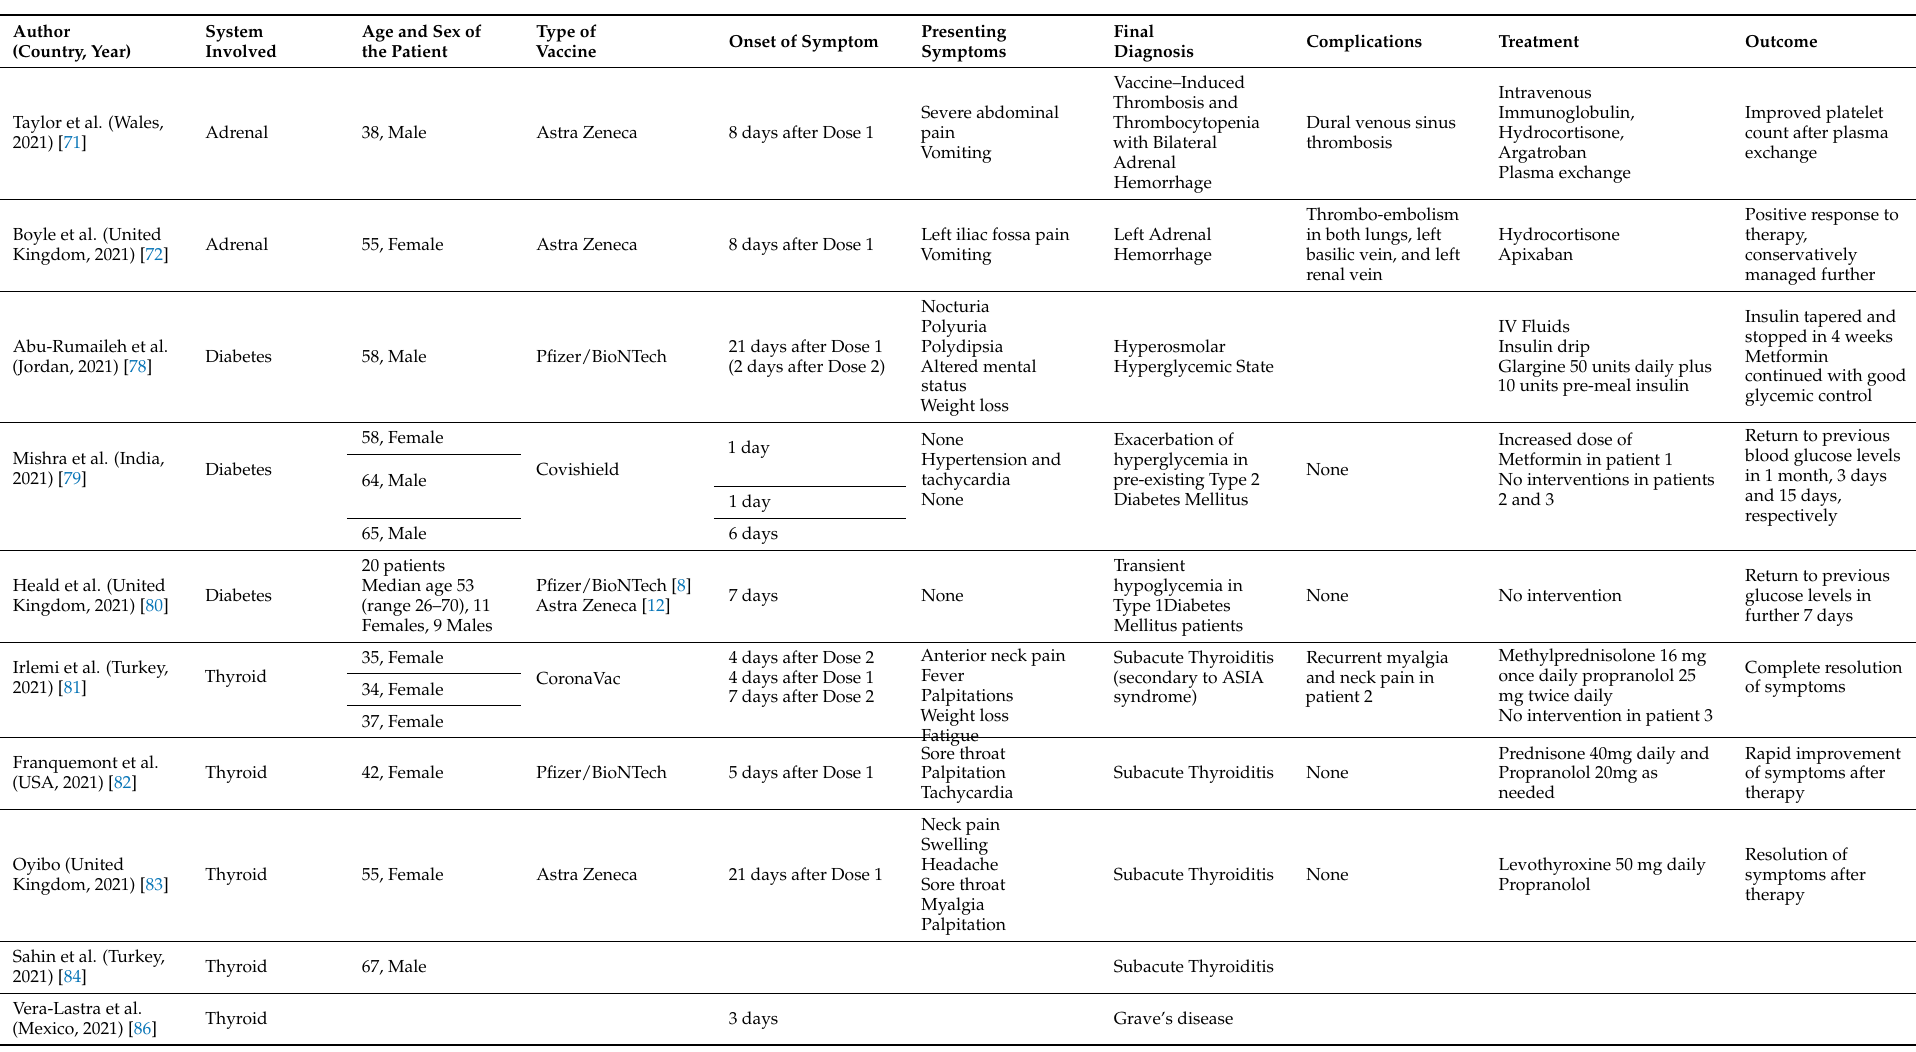
Table 1. Reported endocrinopathies in patients post-COVID-19